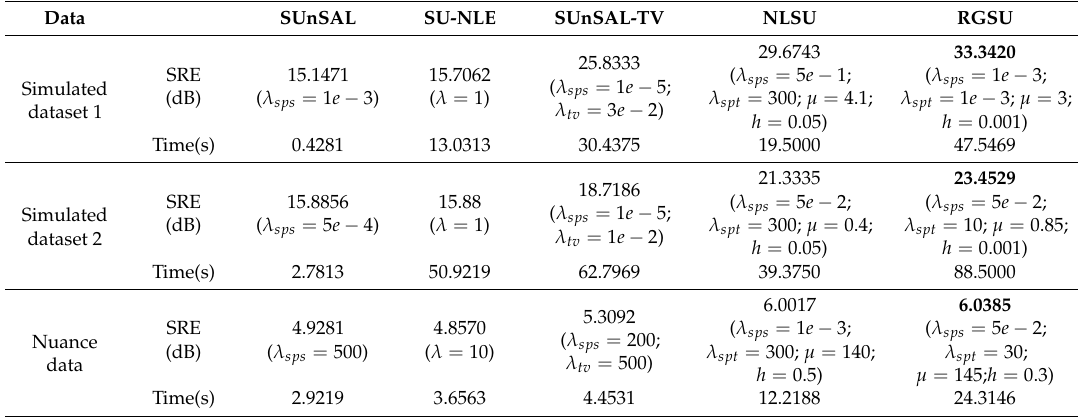
Table 2. Performance comparison for the different methods with the three